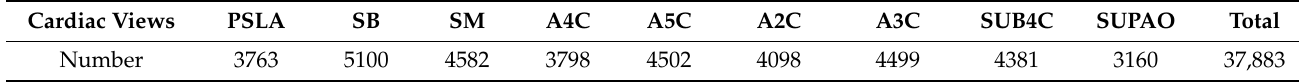
Table 2. Distribution of cardiac views from